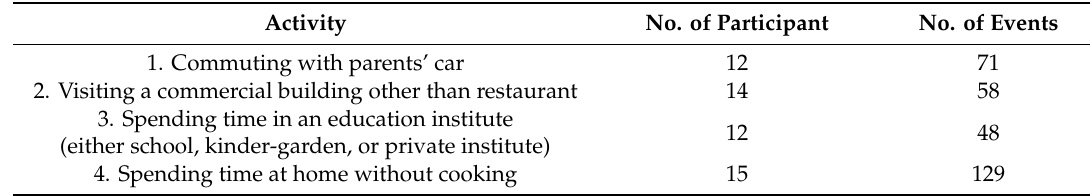
Table 1. The number of individuals who experienced the activity predefined and the pooled number of the activity by all